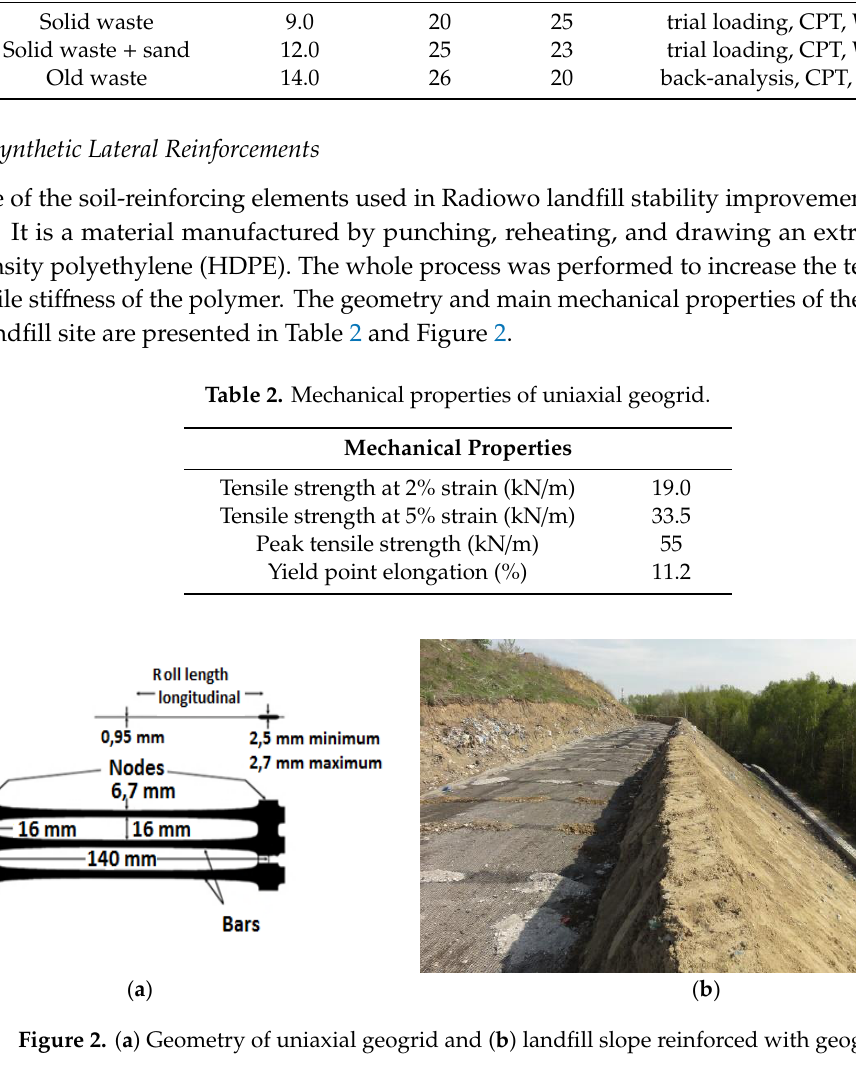
Figure 3. ( a ) Scheme of tire junction with PP- polypropylene tape, and ( b ) tire mattresses built in the landfill slope;